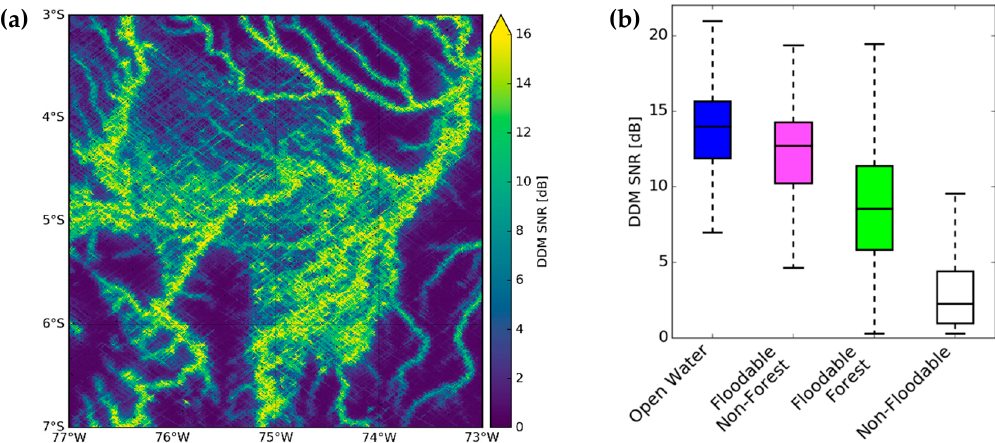
Figure 16. ( a ) Maximum CYGNSS DDM SNR observed between 18 March 2017–15 February 2018, posted at 0.01 ° (~1 km) grid; ( b ) box plot delineating maximum DDM SNR grouped by PALSAR-2 maximum flooded extent class, including only 1 km pixels that are dominantly one class ( ≥ 99%). Central rectangle spans the first quartile to the third quartile (interquartile range), with median value illustrated as line inside the rectangle, and the minimum and maximum values indicated by the extent of the whiskers above and below the